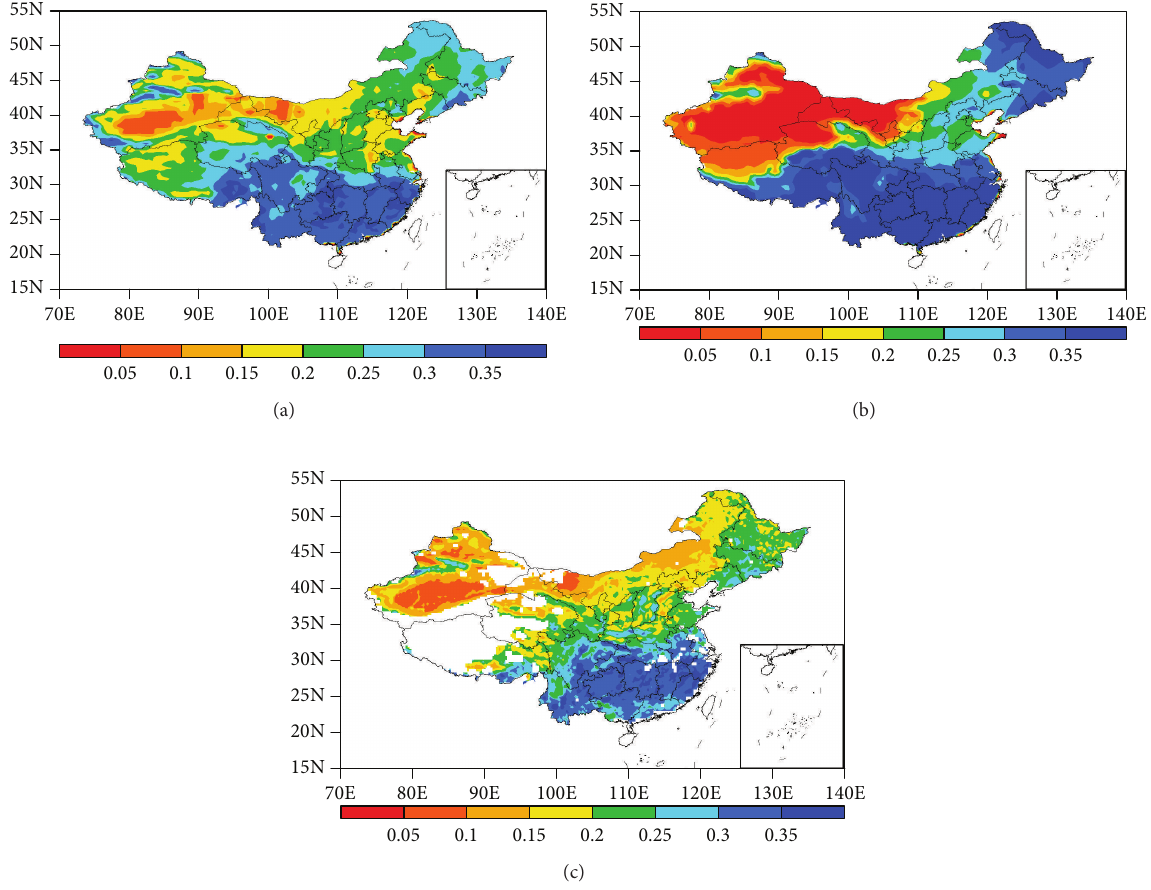
Figure 5: Spatial distribution of SM for April to November of 1981–1999 (unit: m 3 /m 3 ). (a) NCEP SM (0–10cm); (b) ERA Interim/Land (0–7 cm); and (c) SM-MW.